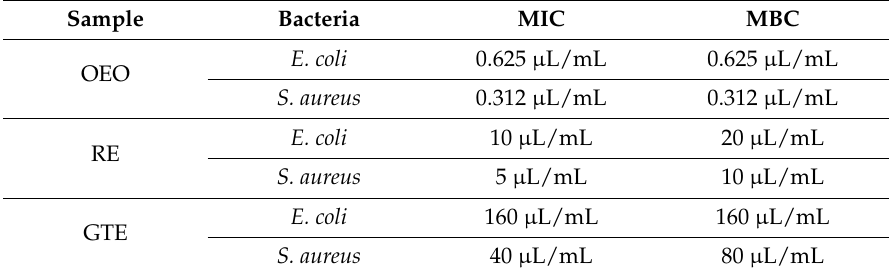
Table 4. Minimum inhibitory concentration (MIC) and minimum bactericidal concentration (MBC) of oregano essential oil (OEO), rosemary extract (RE), and green tea tree extract (GTE) against S. aureus and E. coli